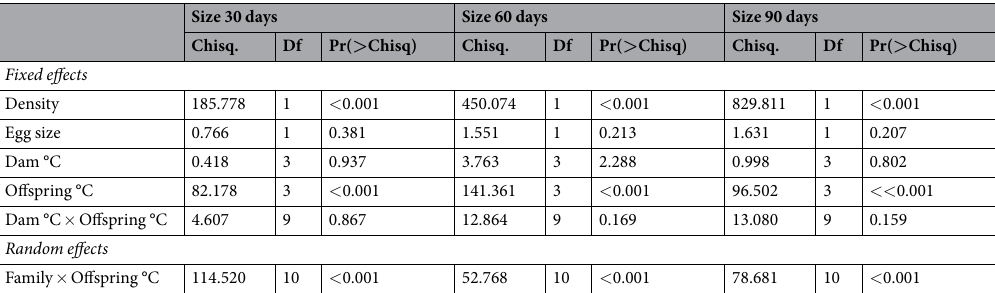
Table 2. Stickleback ( Gasterosteus aculeatus ) offspring body size (standard length) at 30, 60 and 90 d post-hatch analysed using GLMMs depicting the influence of density, egg size, maternal acclimation temperature (Dam °C), offspring rearing temperature (Offspring °C), and their interaction (Dam °C × Offspring °C). Chi square test statistics are given (Chisq.), along with degrees of freedom (Df) and associated p-values (Pr( > Chisq)). The random effect interaction term family (nested within Dam °C) by offspring temperature (Family × Offspring °C) and its Chi square statistics based on likelihood ratio tests between the full and reduced model are also shown. Note: no model selection was performed, hence results denote a full model including all fixed and random effect